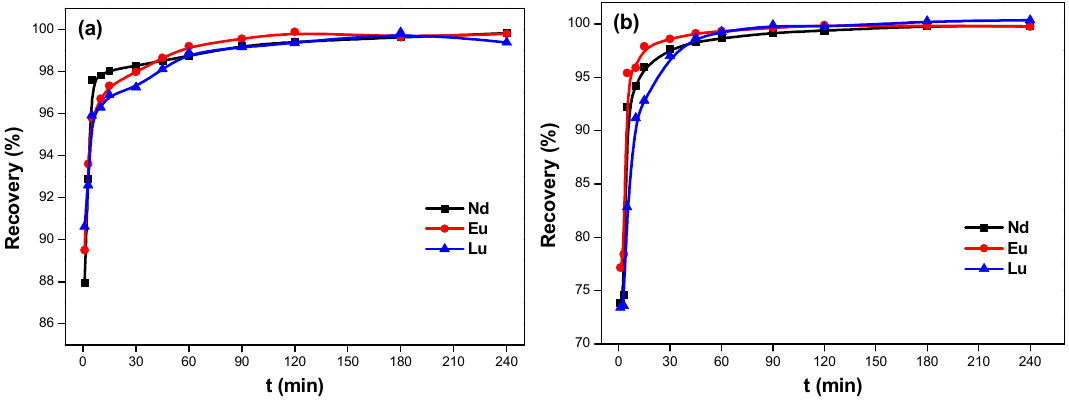
Figure 12. Influence of contact time on the recovery of Nd 3+ , Eu 3+ and Lu 3+ from halloysite ( a ) and illite ( b ). (pH levels for halloysite and illite are 4 and 3, respectively, (NH 4 ) 2 SO 4 concentration = 0.11 mol/L.)